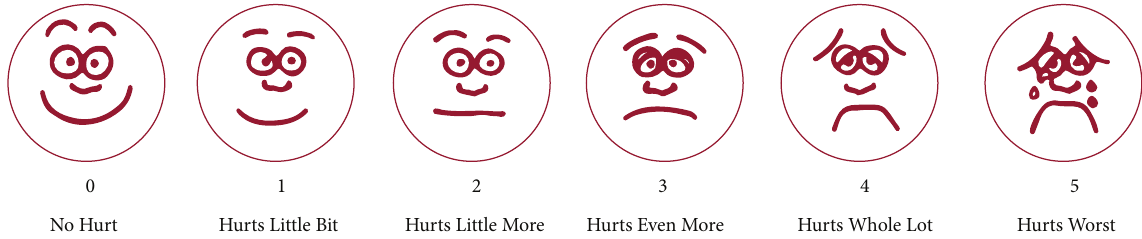
Figure 1: Wong-Baker FACES Pain Rating Scale (reprinted with permission from